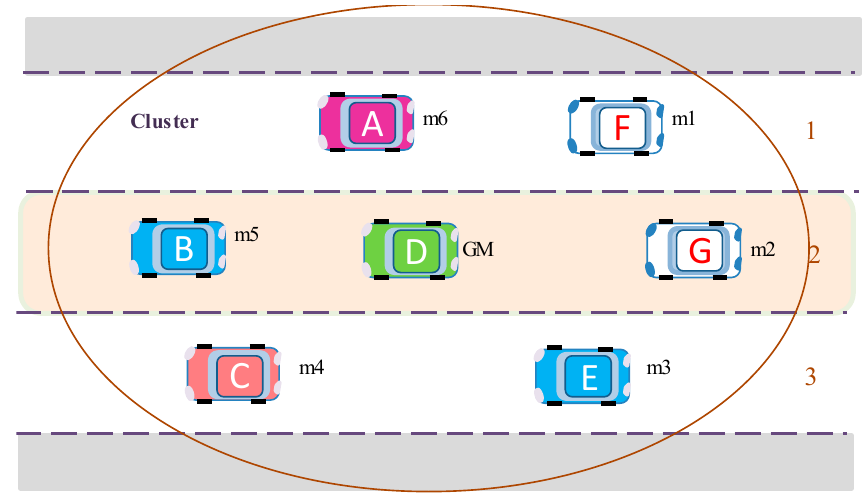
Figure 4. Construct cluster with group manager (GM) and members 𝑚 (cid:3036) .